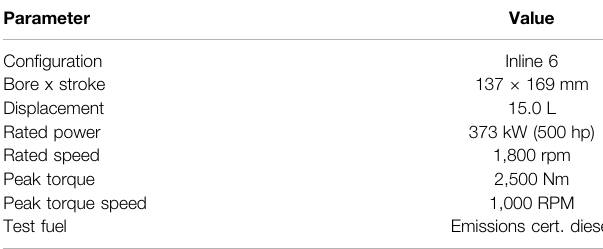
TABLE 2 | Composite FTP emissions with 5 kW EH and CDA.